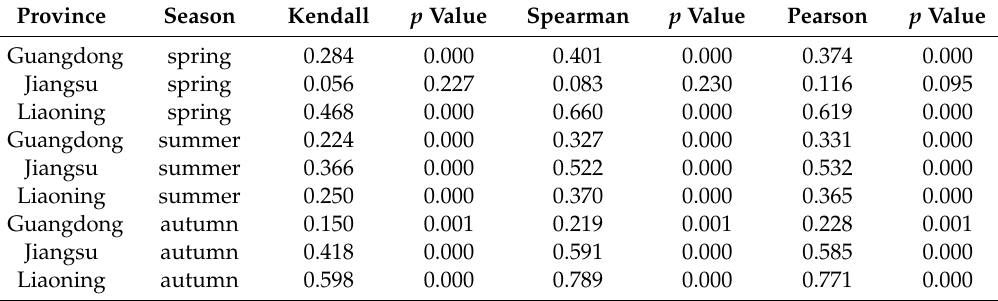
Table 2. Correlation coefficients of Tmax–NDVI in spring, summer and autumn in Guangdong, Jiangsu and Liaoning.